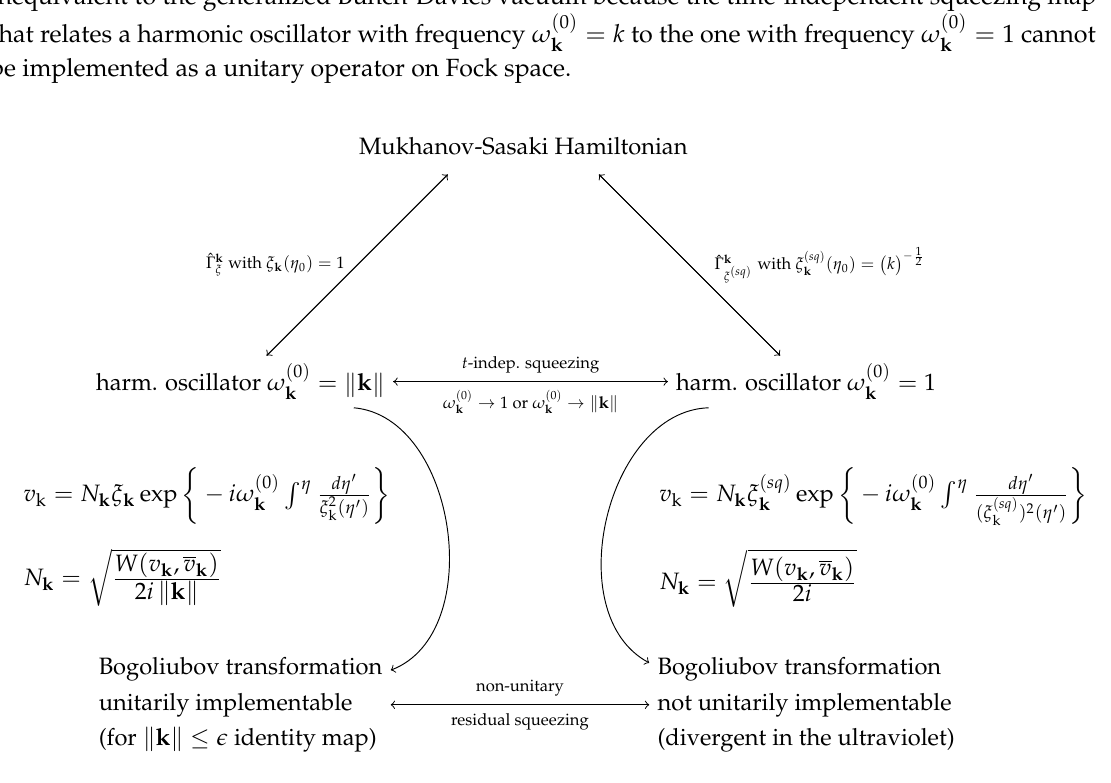
Figure 1. Graphical summary of the two different maps analyzed on Fock